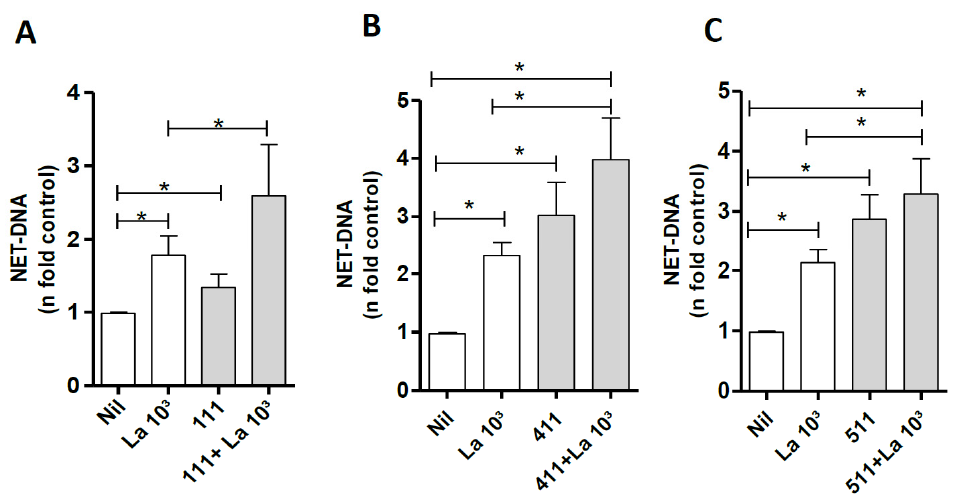
Figure 6. LMs 111, 411, and 511 modulate NETs induced by Leishmania amazonensis (La). Neutrophils were incubated with or without LMs 111, 411, and 511 in solution for 30 min and then further incubated in the presence or absence of La (10 3 ) for 60 min. NETs in culture supernatants were quantified using PicoGreen. The data were normalized according to spontaneous release of DNA (Nil) and are represented as the mean ± SEM of 6 ( A ), 8 ( B ), and 10 donors ( C ). * p < 0.05.